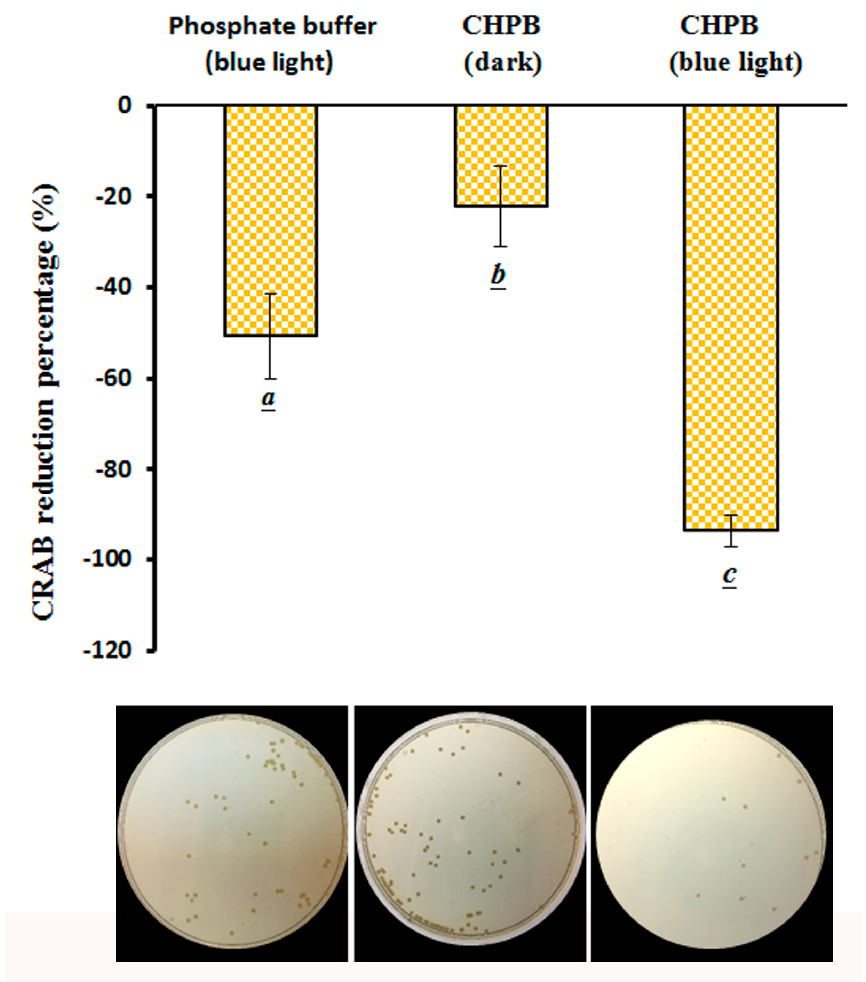
Figure 6. Effects of photochemical treatments on the viability of carbapenem resistant A. baumannii (CRAB) treated with 290 µ g/mL CHPB (pH 7.8) under blue light irradiation at 2.0 mW/cm 2 for 120 min. Data are represented by mean ± SD, where n = 7. Statistical differences ( p < 0.05) between groups are indicated by the different letters below each